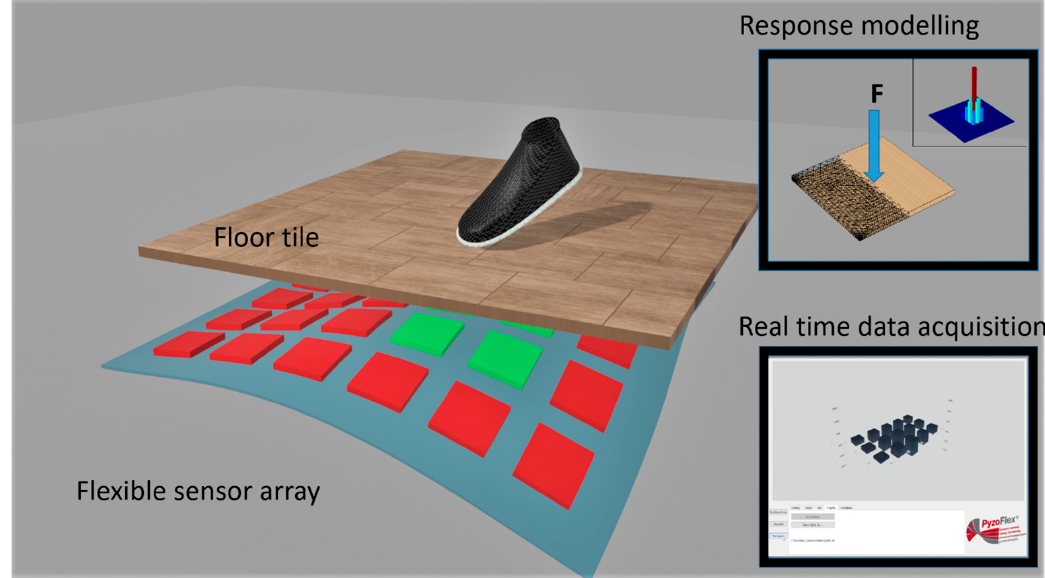
Figure 1. General scheme of the smart floor system. A flexible sensor matrix is attached to the bottom of a floor tile, allowing real-time position sensing of steps or any kind of pressure applied. The generated data are sent (wirelessly) to a computer for signal analysis. This data allows the development of a digital model of the system that can be used to further optimize the sensor array to the specific requirements (e.g., sensitivity, resolution) of the target application, thus avoiding unnecessary pro- totyping and saving costs and time.